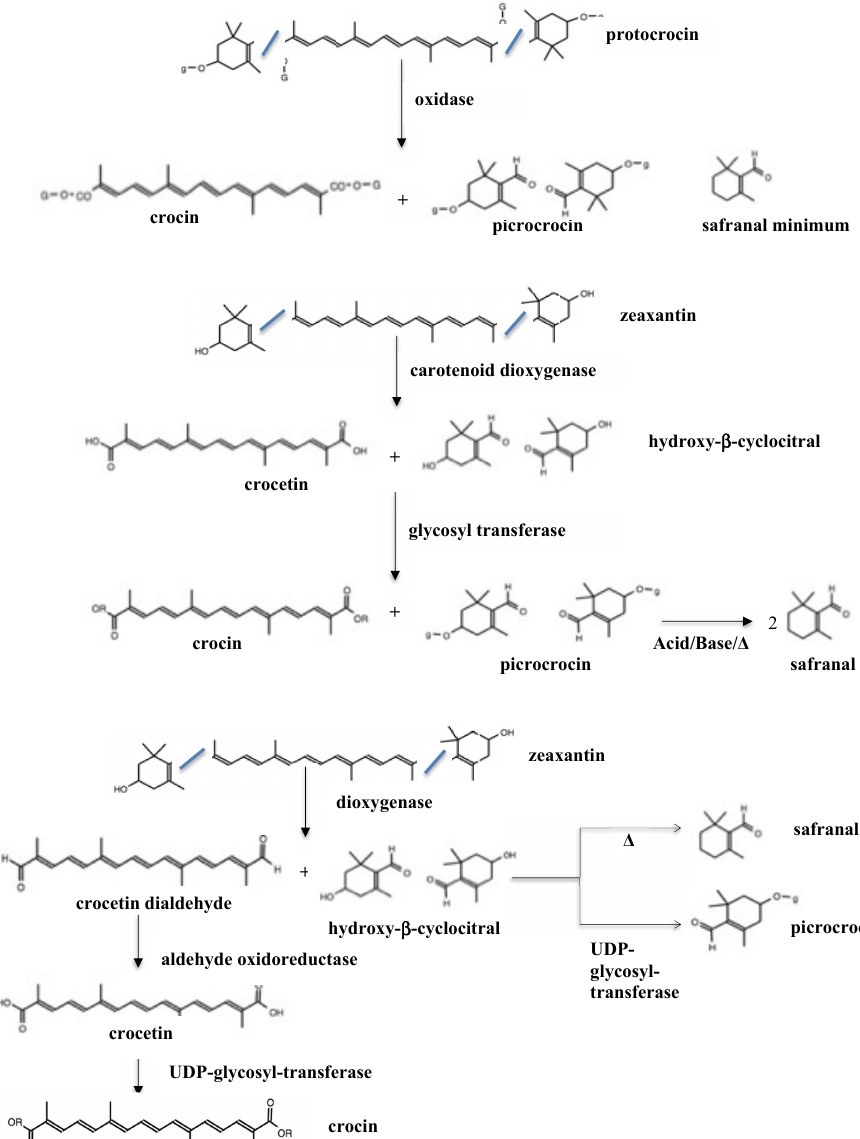
Figure 1. Possible pathways of commercial apocarotenoids in